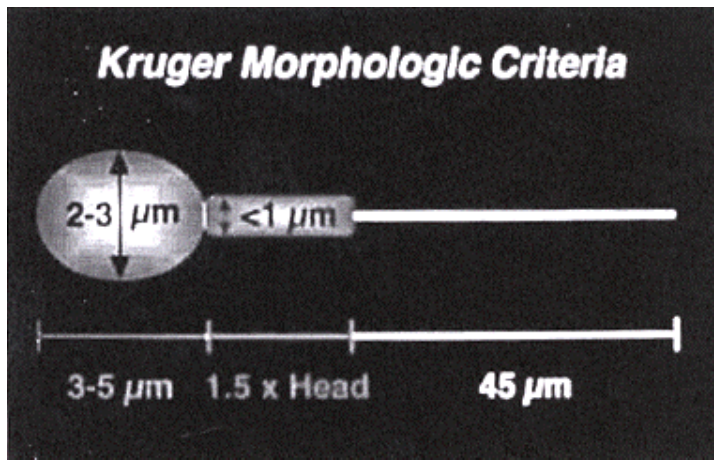
FIGURE 1. Criteria for Kruger strict